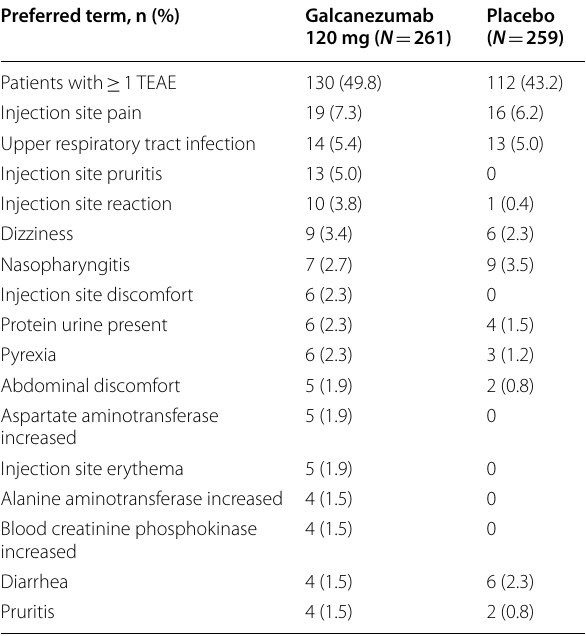
in 1.5% patients in the galcanezumab group ≥